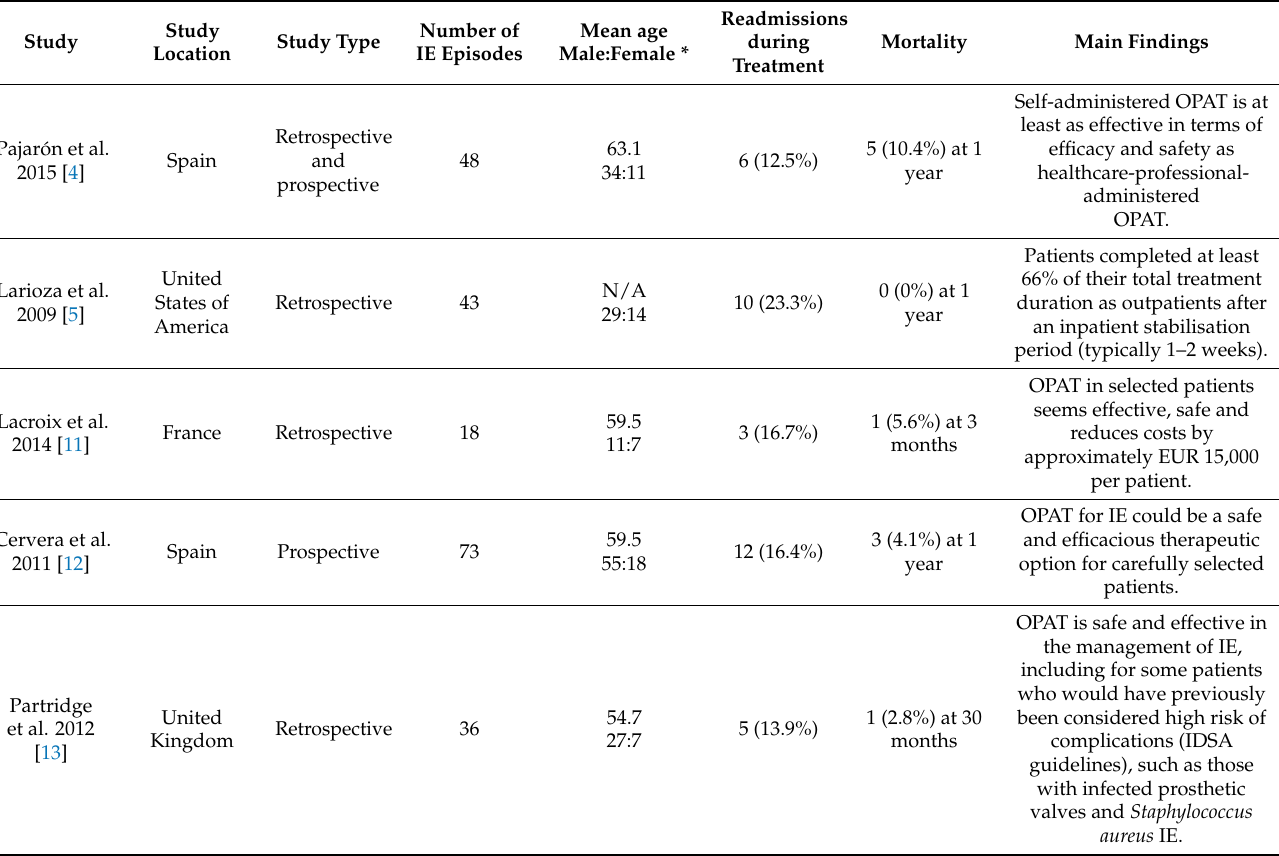
Table 1. Summary of Studies of Outpatient Parenteral Antibiotic Therapy (OPAT) in Infective Endocarditis